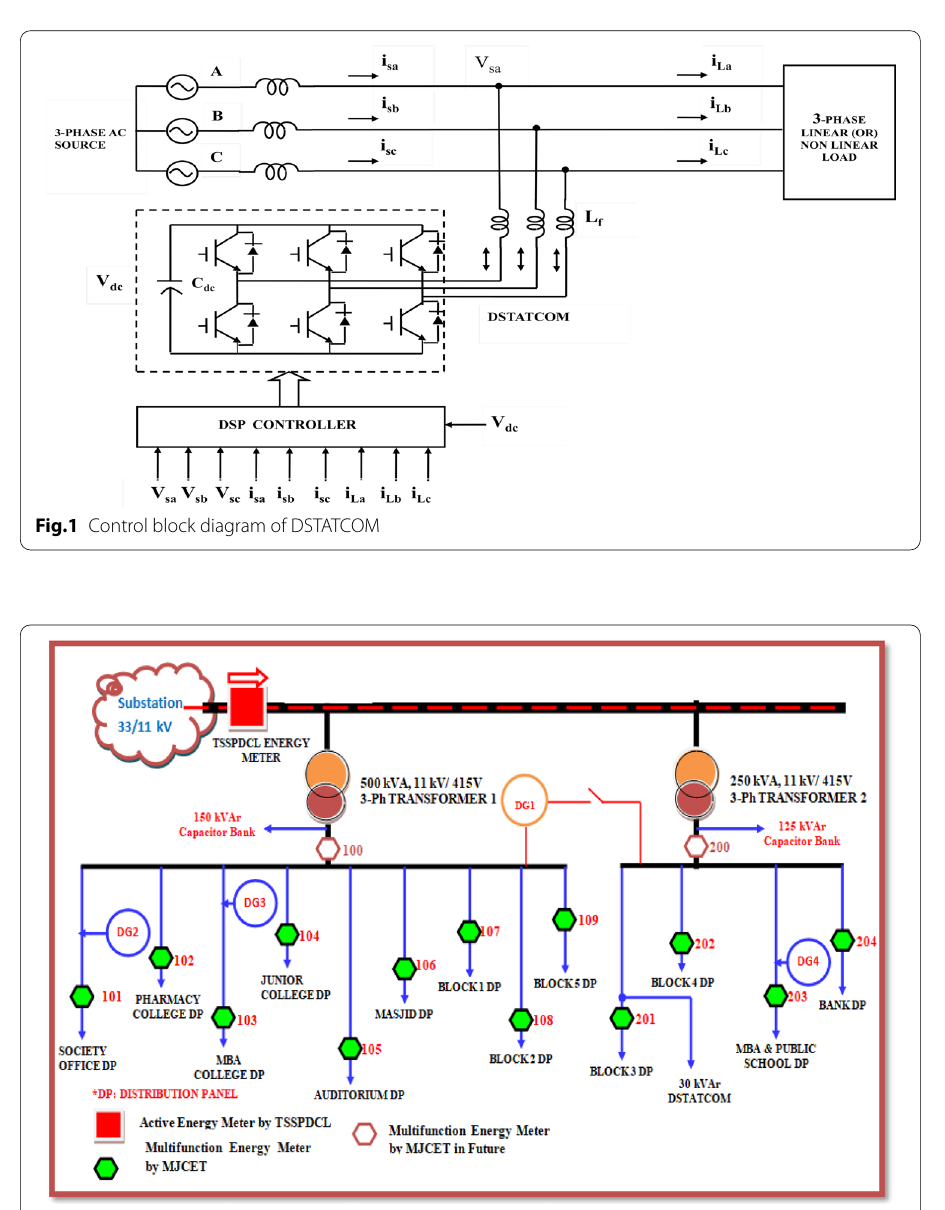
Fig. 2 Power distribution of Sultan-Ul-Uloom Educational